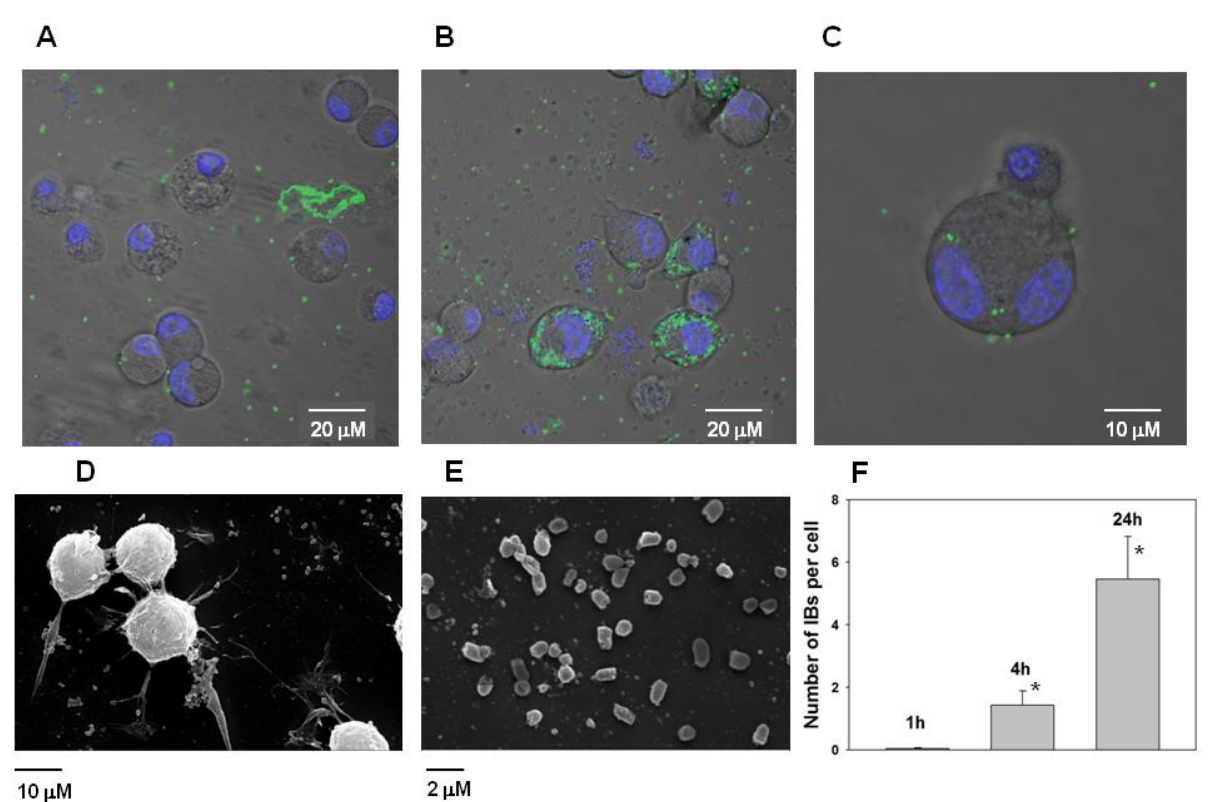
Figure 11. Fluorescence image of mouse neuroblastoma Neuro-2a cells after incubation with PldA-GFP IBs (20 µ g/mL) for 4 ( A ) and 24 h ( B ). Images are obtained by superimposing the passing and fluorescent channels. Fluorescence of IBs is shown in green (GFP), cell nuclei are shown in blue (Hoechst 33342). An enlarged image ( × 5) of a neuroblastoma cell with included PldA-GFP IBs inside ( C ); Scanning electron microscopy of Neuro-2a mouse neuroblastoma cells with adsorbed PldA-GFP IBs ( D ); and magnified image ( × 5) of PldA-GFP IBs alone ( E ). The average amount of PldA-GFP IBs in a single neuroblastoma Neuro-2a cell after incubation for 1, 4, and 24 h ( F ). The fluorescent images of 150 randomly selected cells for each time point were inspected, and the amount of fluorescent IBs penetrating the cell surface was calculated and expressed as number of PldA-GFP IBs per cell. The data are presented as the mean ± SEM values ( n = 150); * p < 0.05 compared with 1 h.